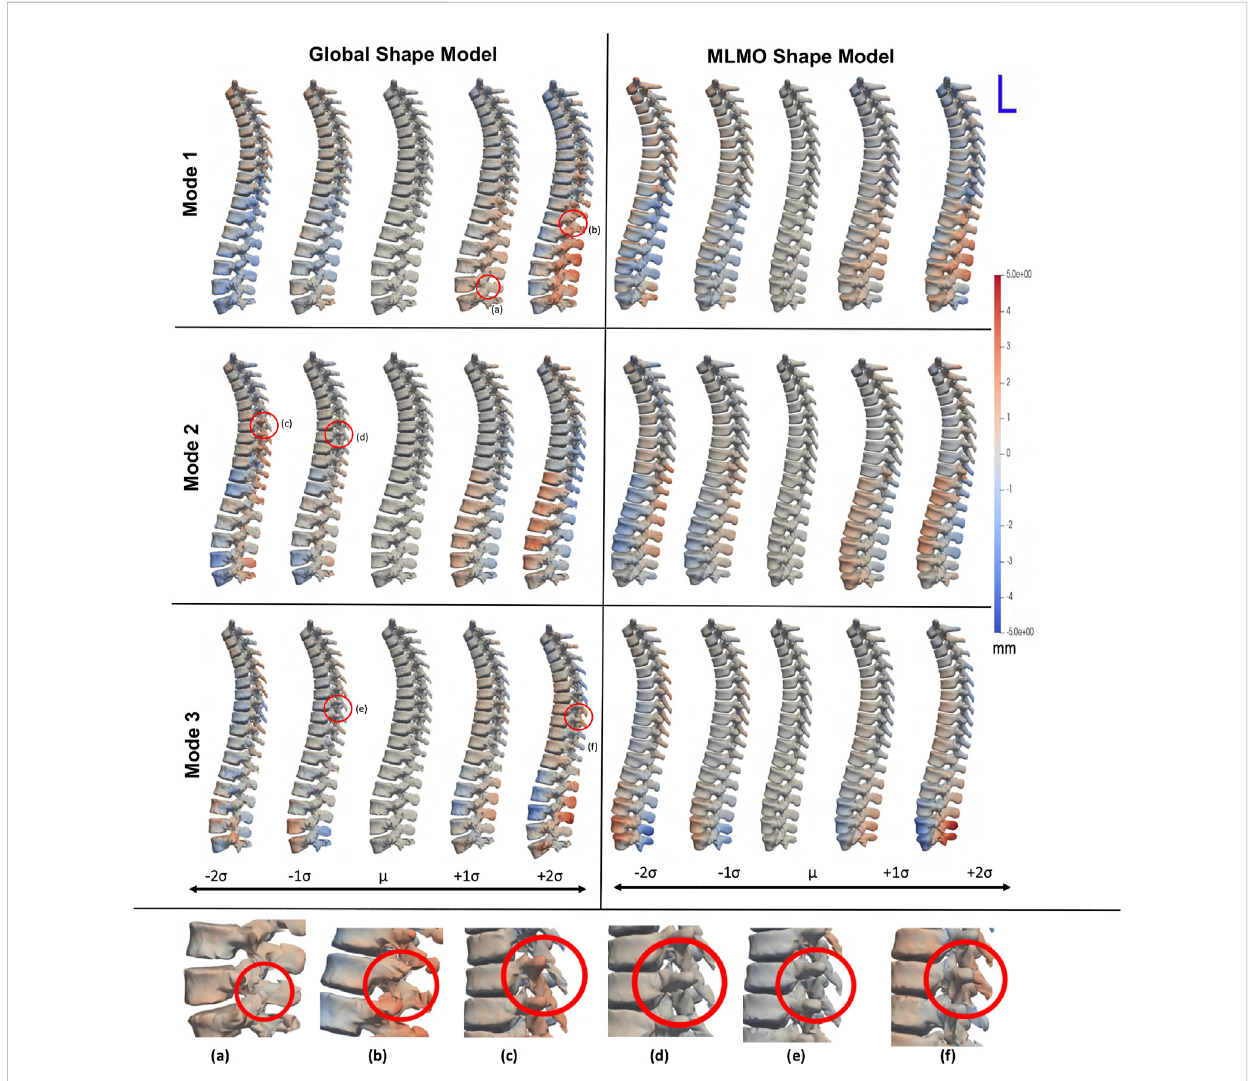
FIGURE 3 Within-organmodesofvariationshowingmorphologicalchangesineachvertebra.Thecolormapshowsthedistanceofeachmodefromthemean shape. Some of the anatomical inconsistencies are highlighted in red circles labeled from (A – F)